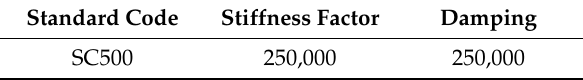
Table 9. Stiffness and damping factors of the buffer